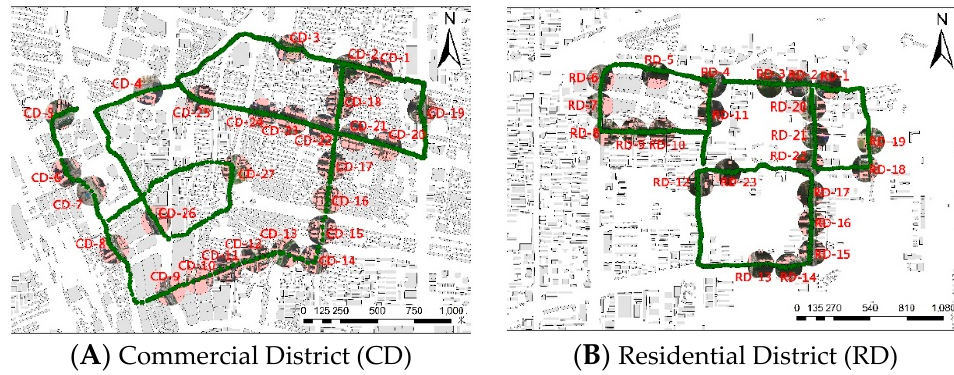
Figure 3. Locations of the Er-qi commercial district and 27 sampling circle areas ( A ), locations of the Yanzhuang residential district and 23 sampling circle areas ( B ). Table 1. Urban morphology index of each site of the commercial district.